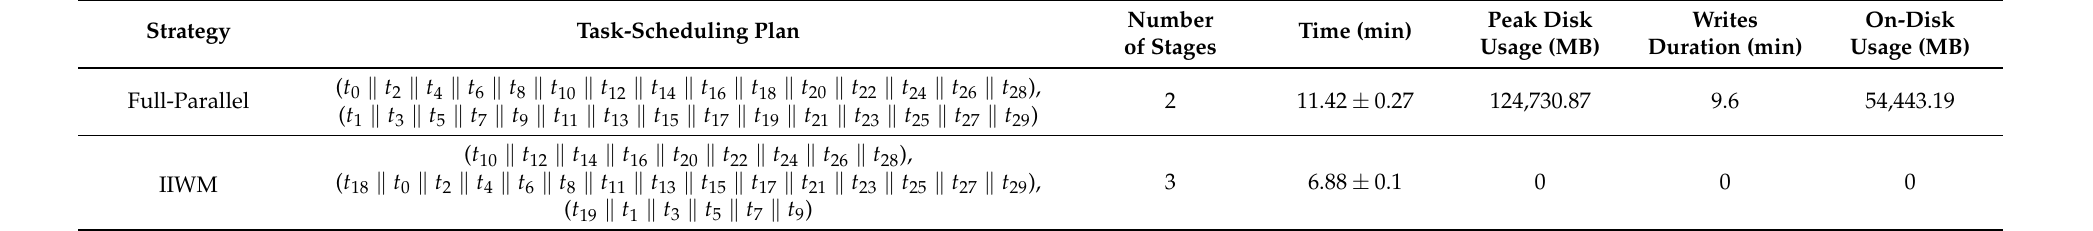
Table 13. Scheduling plan and statistics about execution times and disk usage with 14 GB of